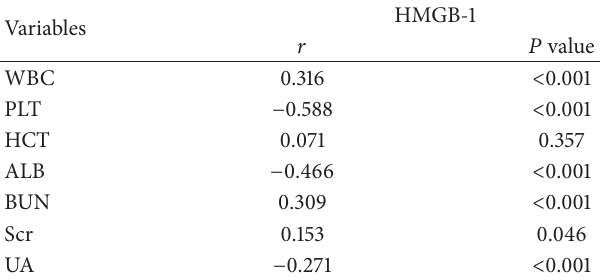
Table 4: Pearson correlation analysis in patients with HFRS.